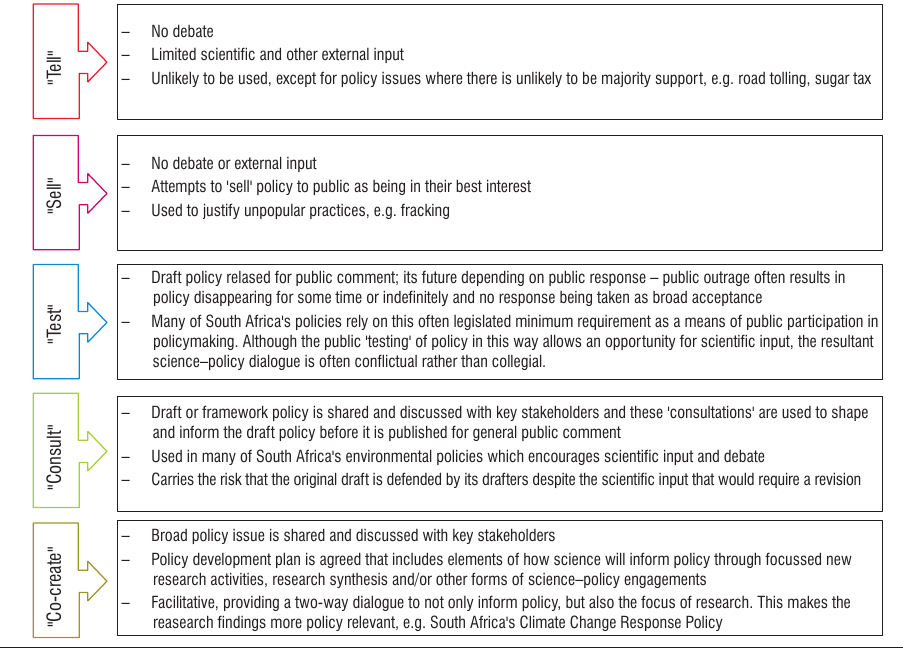
Figure 1: Senge’s 11 five decision-making strategies may be used as a framework to describe policymaking in South Africa and the opportunities for evidence-based policymaking associated with each